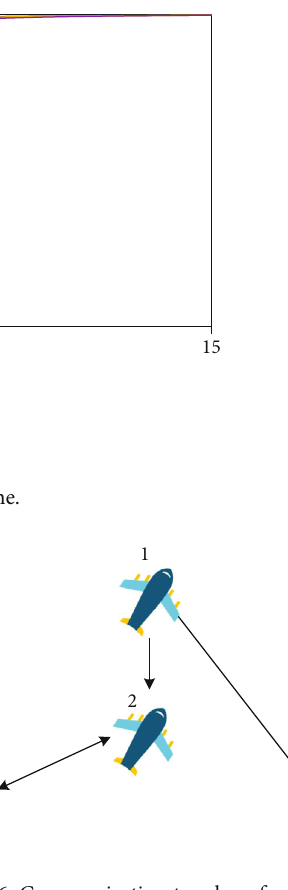
Figure 6: Communication topology for 4 fi